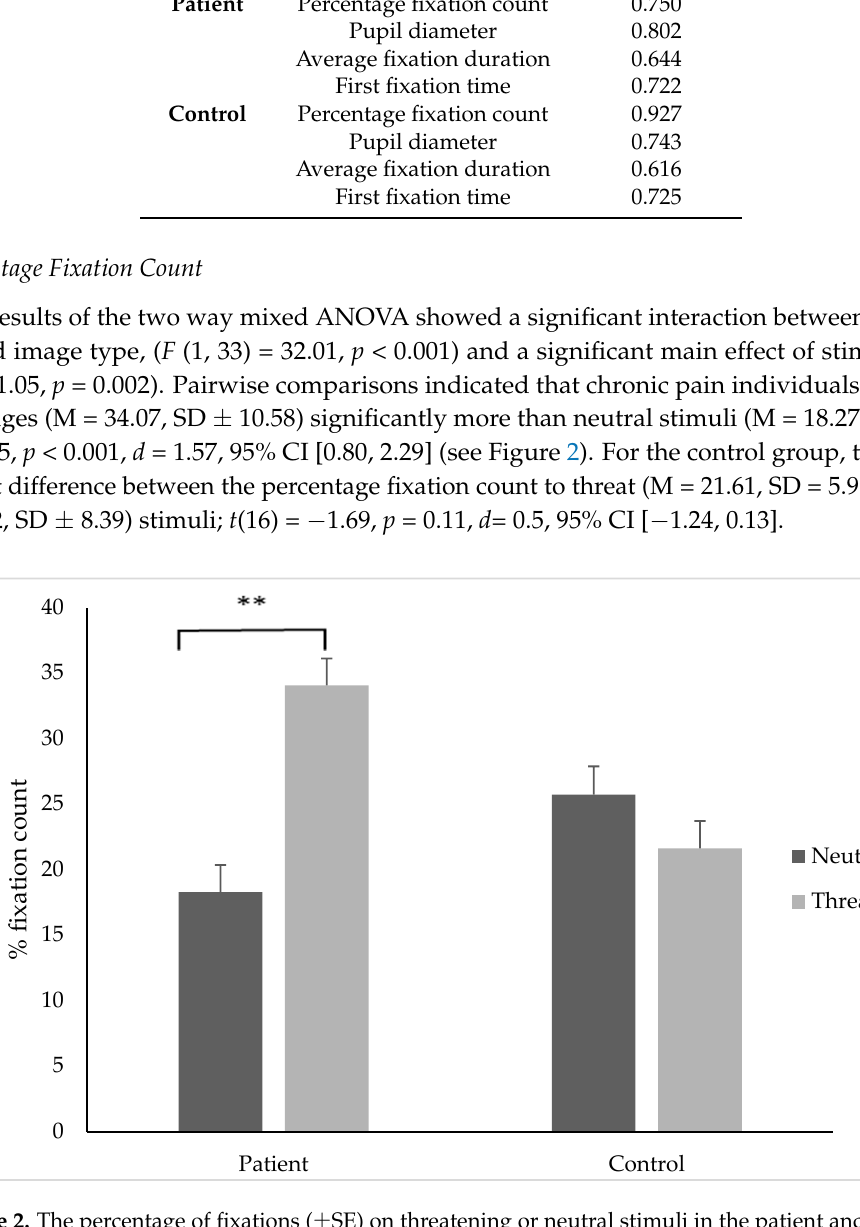
Figure 2. The percentage of fixations (±SE) on threatening or neutral stimuli in the patient and control group. ** indicates p < 0.01.